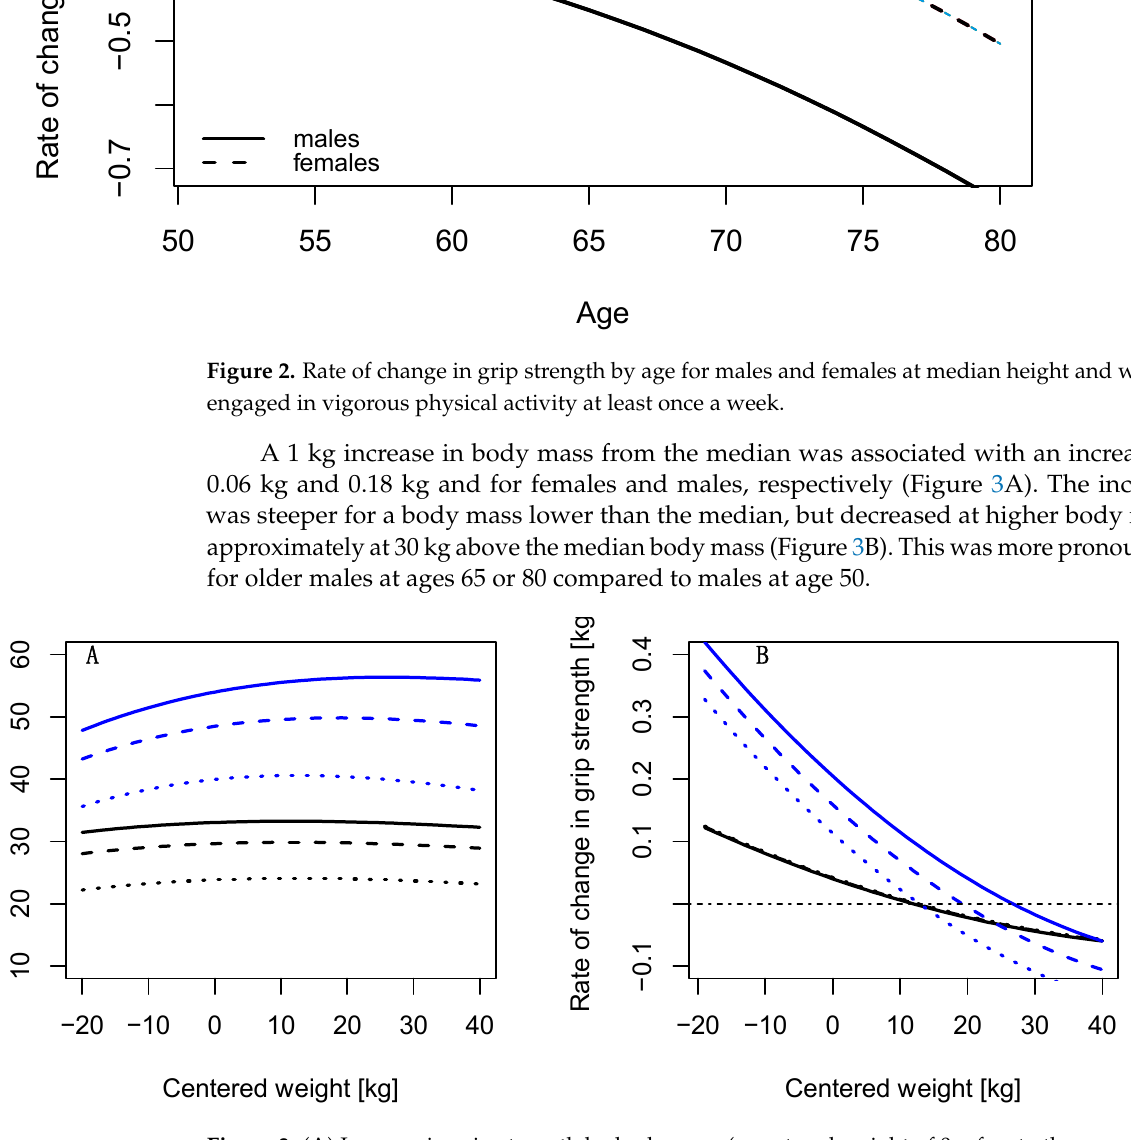
Figure 3. ( A ) Increase in grip strength by body mass (a centered weight of 0 refers to the mean body mass at age 50 (82 kg for males, 68 kg for females) shown at ages 50, 65, and 80. ( B ) Rate of change in grip strength by body mass (a centered weight of 0 refers to the mean body mass at age 50) shown at ages 50, 65, and 80. A caption on a single line should be centered.